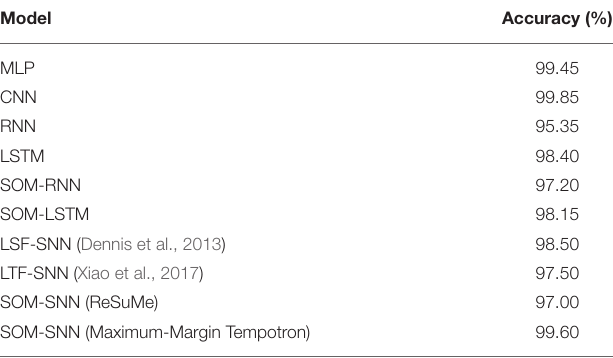
TABLE 2 | Comparison of the classification accuracy of the proposed SOM-SNN framework against other baseline frameworks on the TIDIGITS dataset.